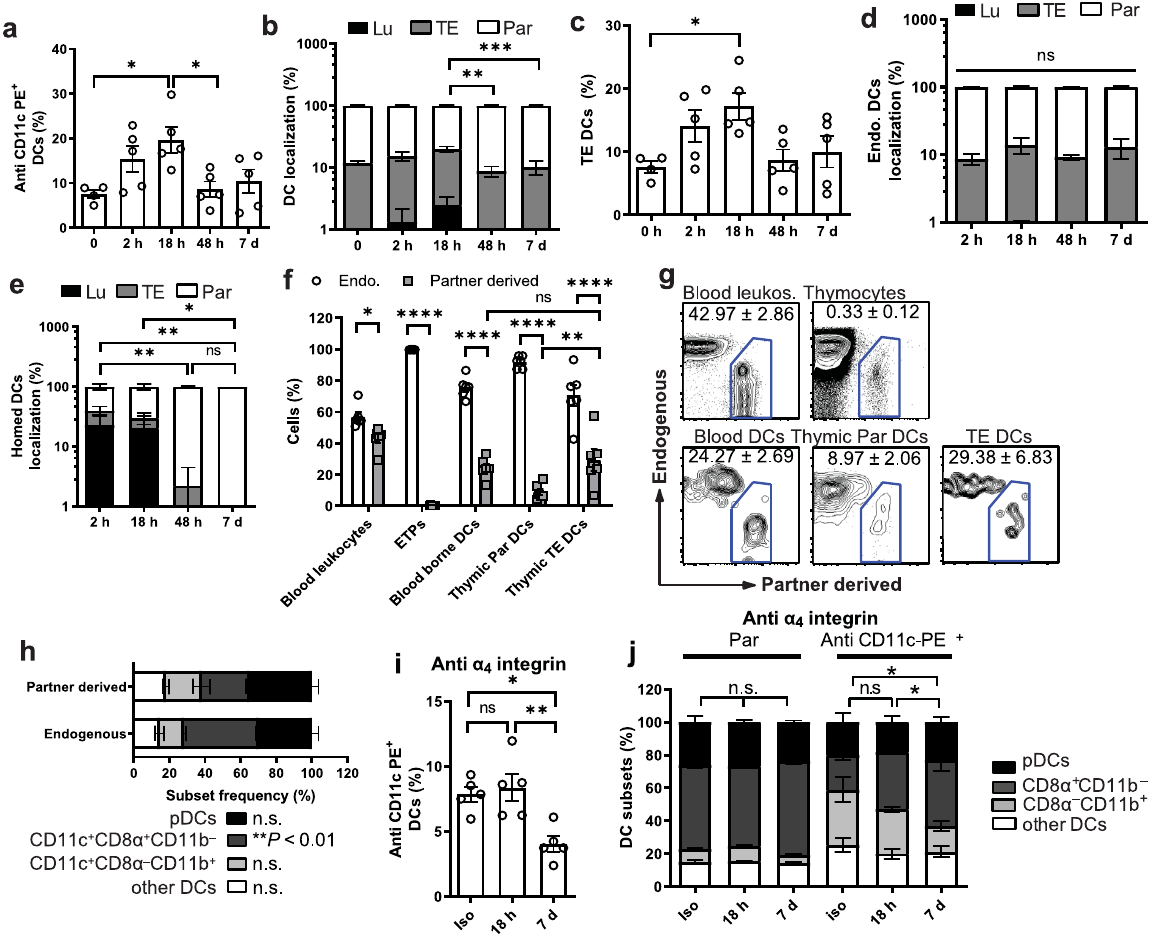
Fig. 5 Origin of thymic TE-DCs. a – e C57BL6 mice (CD45.1 + ) were injected with congenic (CD45.2 + ) splenic DCs and analyzed at indicated time points. Two minutes prior to tissue harvest, mice received anti-CD11c-PE mAb IV ( n = 3 experiments with fi ve mice/group). Labeling indices were determined to identify DC localization as illustrated in Supplementary Fig. 3 and Fig. 4a. a Frequency of PE + DCs among total DCs recovered from thymi before and after adoptive DC transfer (one-way ANOVA). b Frequency of TE-DC, Lu-DC, and Par-DC among total thymic DCs (two-way ANOVA) and c frequency of TE- DCs at indicated time points before and after DC transfer (one-way ANOVA). d Localization of endogenous DCs and e homed DCs at the indicated time points (two-way ANOVA). f – h Parabiotic pairs were generated by surgically joining age- and sex-matched CD45.1 + and CD45.2 + congenic mice. Two weeks after parabiosis surgery, animals were injected with anti-CD11c-PE and tissues were harvested 2 mins later. n = 2 experiments with fi ve mice/group (two-way ANOVA). f Frequency of endogenous (empty bars) and partner-derived ( fi lled bars) leukocytes, early thymic progenitors (ETPs), and DCs in blood and thymus. g Representative FACS plots of leukocytes and DCs in parabiotic animals. h Subset composition of endogenous and partner-derived thymic DCs. i and j Effect of α 4 integrin inhibition on thymic DC subsets. C57Bl/6 mice were either treated for up to 7 days with a blocking anti- α 4 integrin mAb or isotype control (Iso). Mice received anti-CD11c-PE mAb 2 mins prior to tissue harvest ( n = 2 experiments with fi ve mice/group; two-way ANOVA). i Frequency of CD11c-PE + cells among total thymic DCs (one-way ANOVA). j Subset composition of thymic Par-DC and anti-CD11c-PE + DCs (two-way ANOVA). Bars and error bars represent mean ± SEM. a * P = 0.0236 (0 h vs. 18 h) and P = 0.0302 (18 h vs. 48 h). b *** P = 0.0009, ** P = 0.0068. c * P = 0.0405. e ** P = 0.005 (2 h vs. 48 h) and P = 0.005 (2 h vs. 7d), * P = 0.0488 (18 h vs. 7d). f ** P = 0.0019, * P = 0.041, **** P <